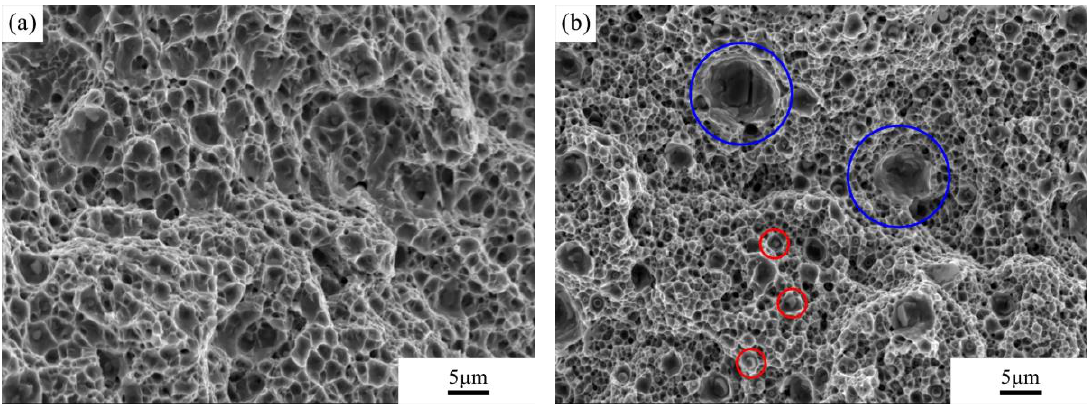
Figure 8. SEM micrographs of the fractures for specimens after tensile testing: ( a ) one specimen with higher tensile strength and elongation and ( b ) one specimen with lower tensile strength and elongation.